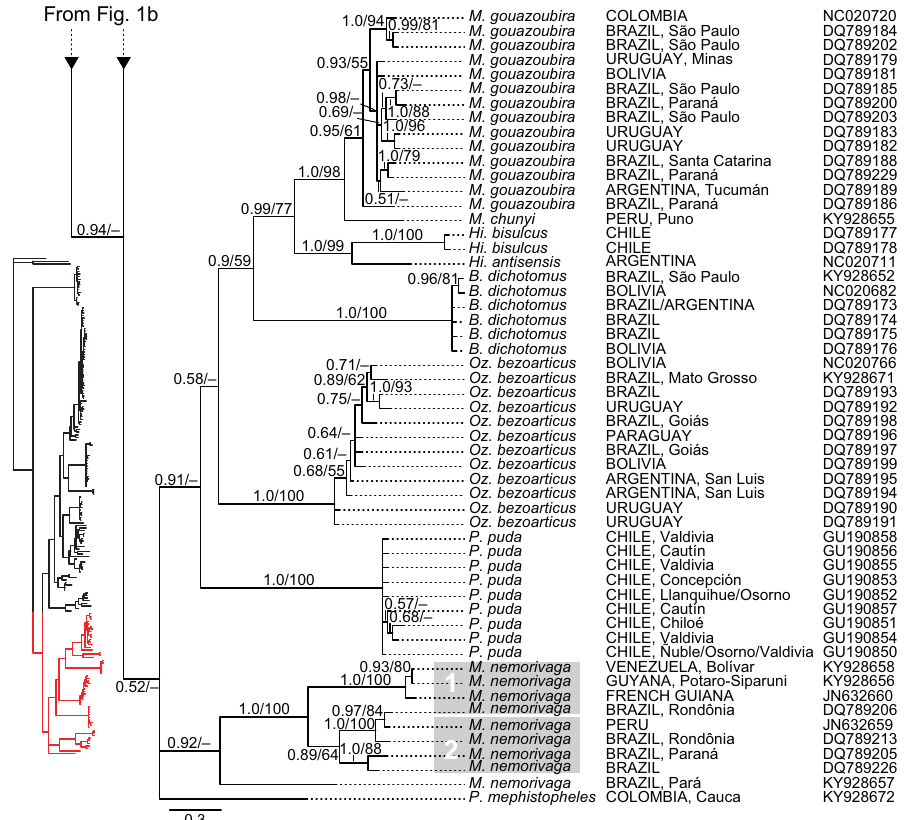
Figure 1c. Phylogenetic tree of cytochrome- b sequences of Odocoileini (continuation). This is a strict consensus topology resulting from the Bayesian inference analysis. Nodal support is indicated at each node, except where the relationship received negligible support. Posterior probabilities (from the Bayes- ian inference analysis) and bootstrap values (from the maximum-likelihood analysis) are indicated before and after the slashes (“/”) at branches of interest (i.e., nodal support for fairly shallow relationships within intraspecific haplogroups are omitted). The scale represents substitutions per site. For each terminal, coun- try of origin and next-largest administrative unit (state, department, province, etc.) are provided (when reported by the team that generated them; see detailed voucher and locality information in supplementary file 1 for sequences that we generated). GenBank accession numbers are indicated for each